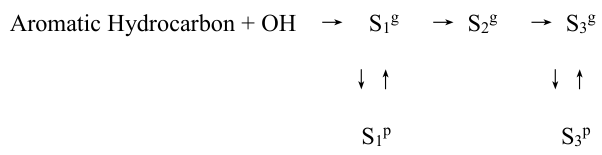
observed yield trend is attributed to the increasing methyl group number enhancing aromatic fragmentation and in-